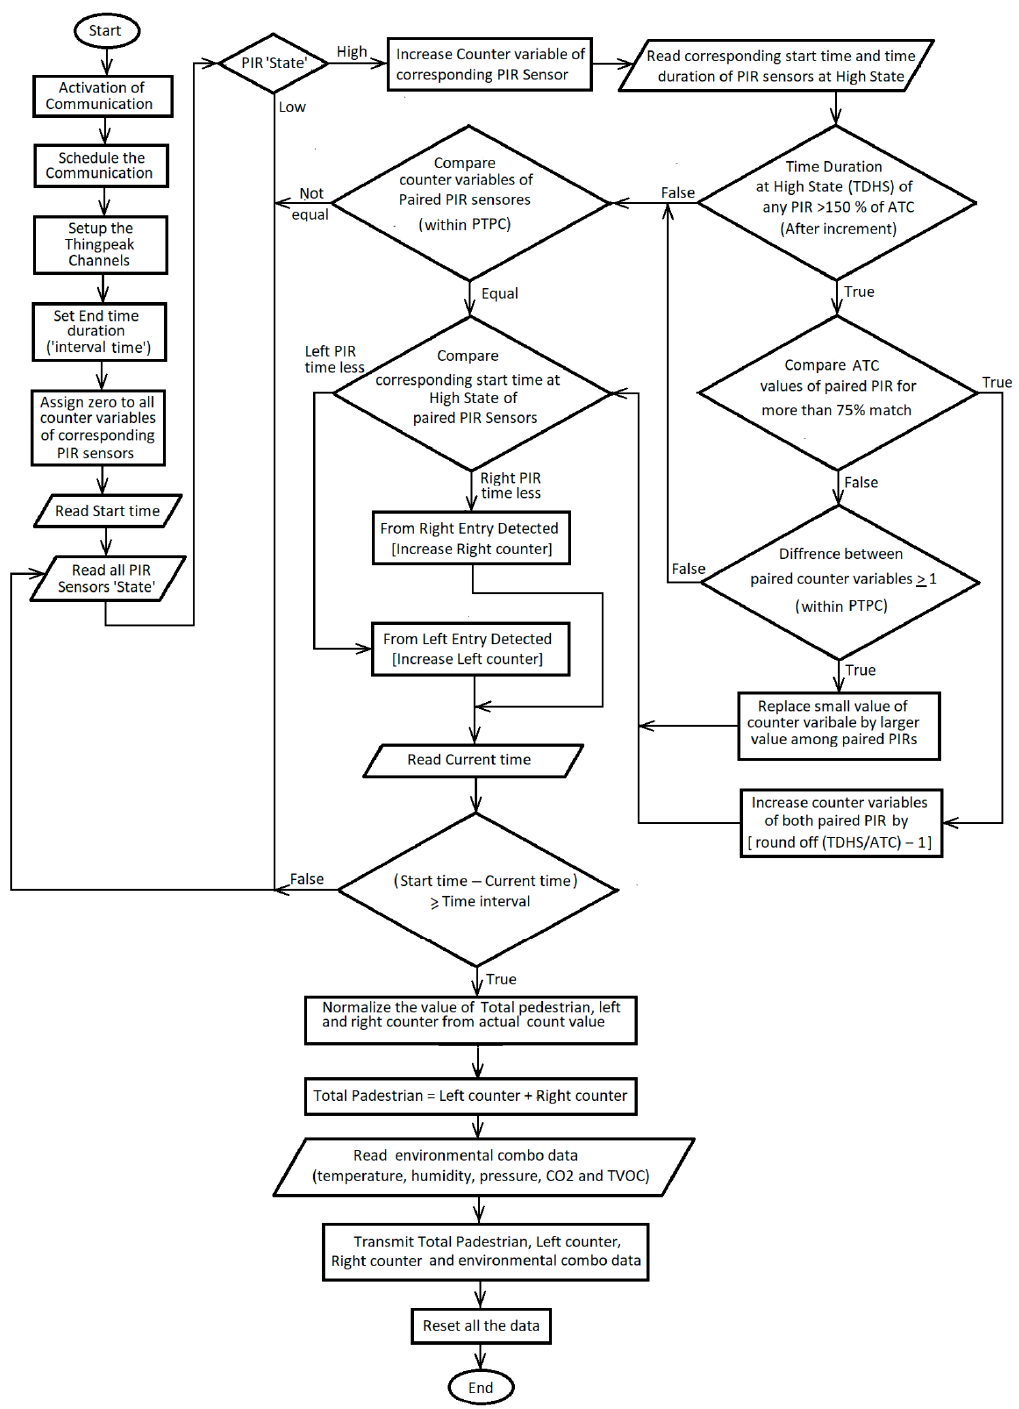
Figure 6. Flow chart of the pedestrian count, direction of travel and environmental monitoring system for a smart city.